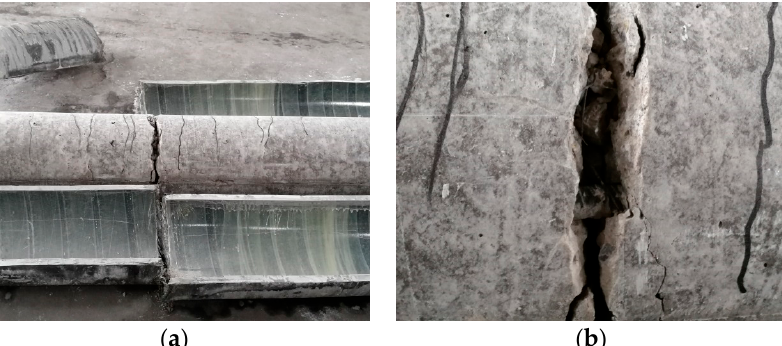
Figure 9. The crack development in the internal concrete of the BFRPC composite column specimen: ( a ) Overall view of cracks; ( b ) crack in the mid-span.